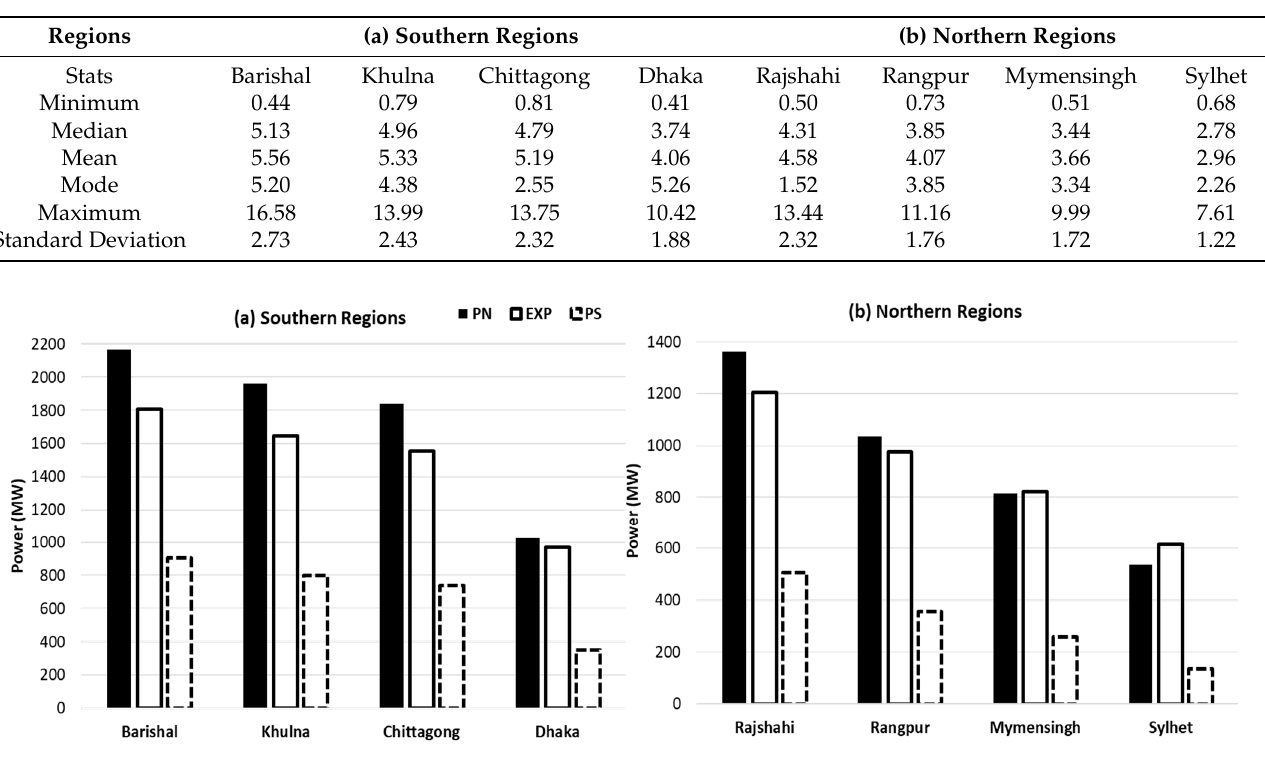
Figure 10. Annual energy production for ( a ) southern Regions and ( b ) northern regions in Bangladesh by SPPM estimations, i.e., Polynomial (PN), Exponential (EXP), and Physical (PS) models. Table 6. SPPM prediction error (%) in annual energy